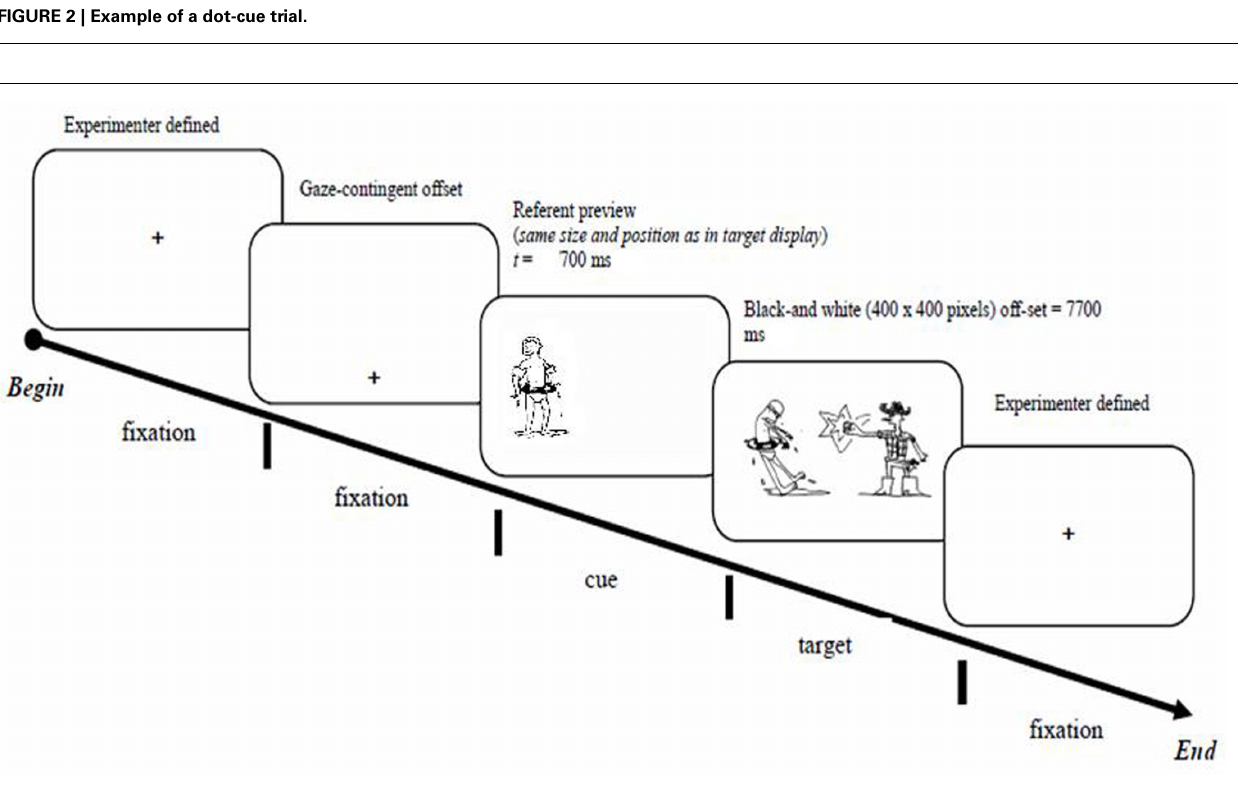
the Cue Type. There was no specific instruction as to how the cues should be treated. After the cue presentation, the target picture appeared on the screen. Participants were instructed to